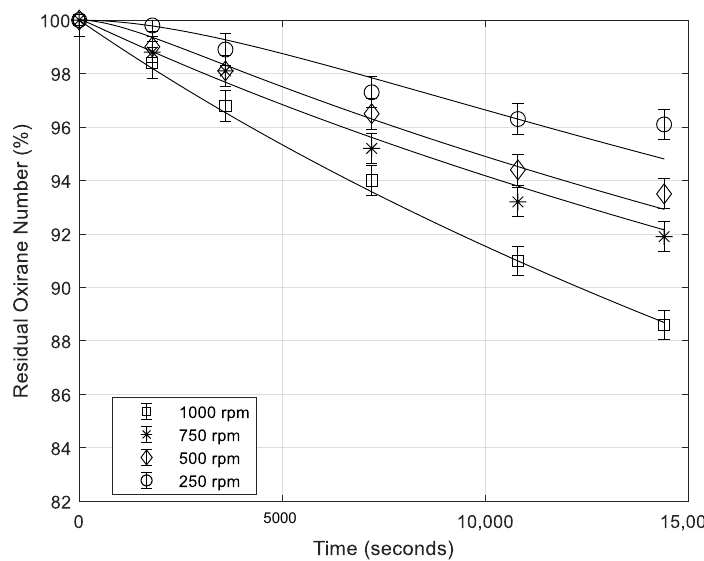
Figure 1. Residual oxirane number profiles vs. time for different stirring rate (rpm = rotations per minute). Points are experimental data lines that are calculated with the developed model (mass of catalyst 0.65 g; temperature 70 °C; mass of formic acid 5.38 g).